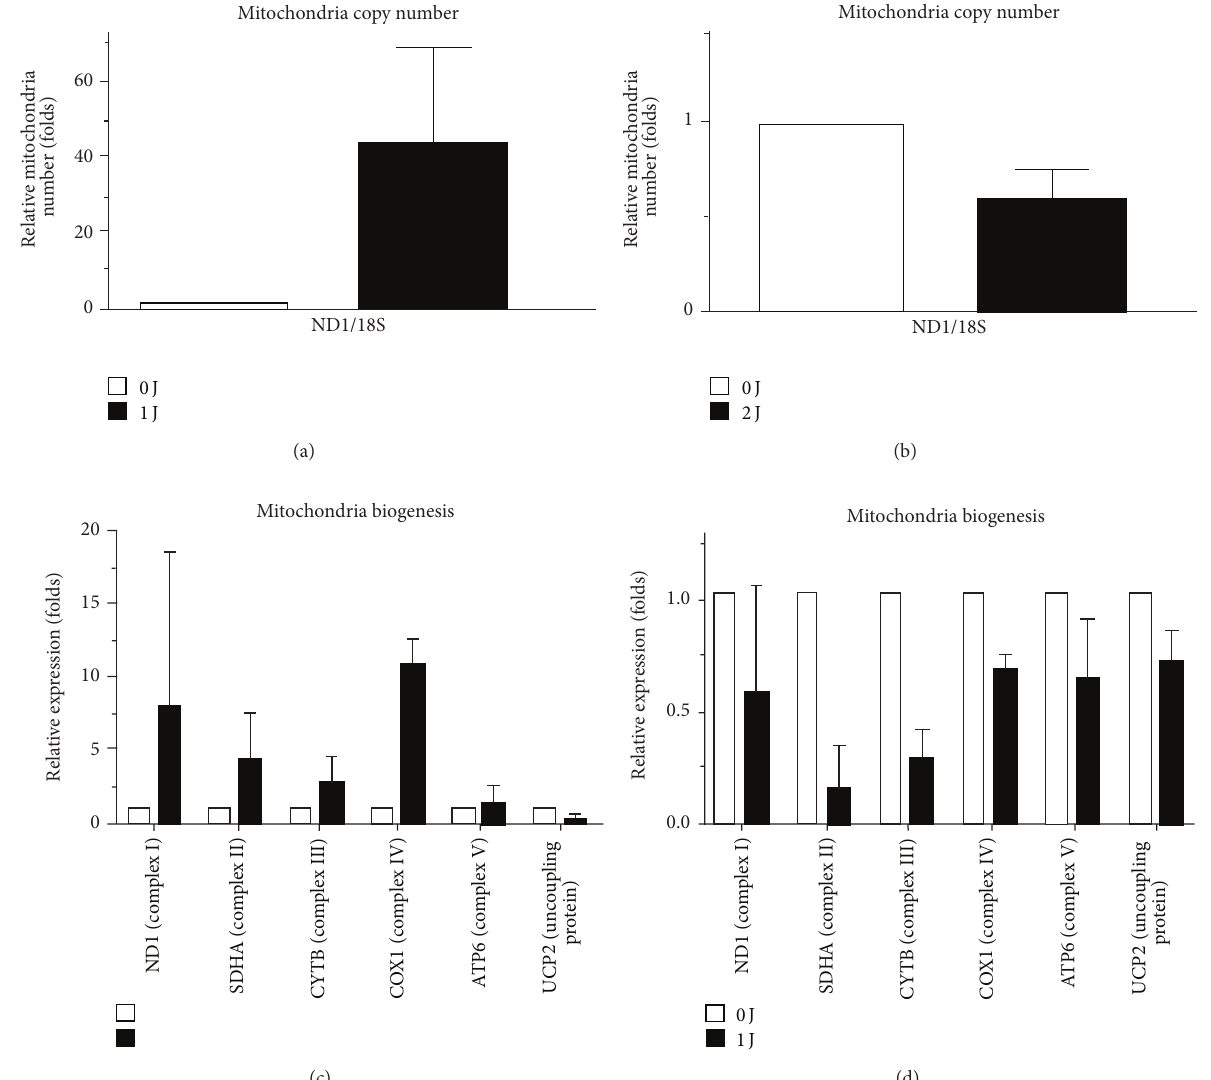
Figure 5: OneJ/cm 2 of LLLT increased the copy number of mitochondria, whereas 2 J/cm 2 did not ((a) and (b)). OneJ/cm 2 of LLLT increased the mRNA expression of complexes I to V and uncoupling protein, whereas 2J/cm 2 did not ((c) and